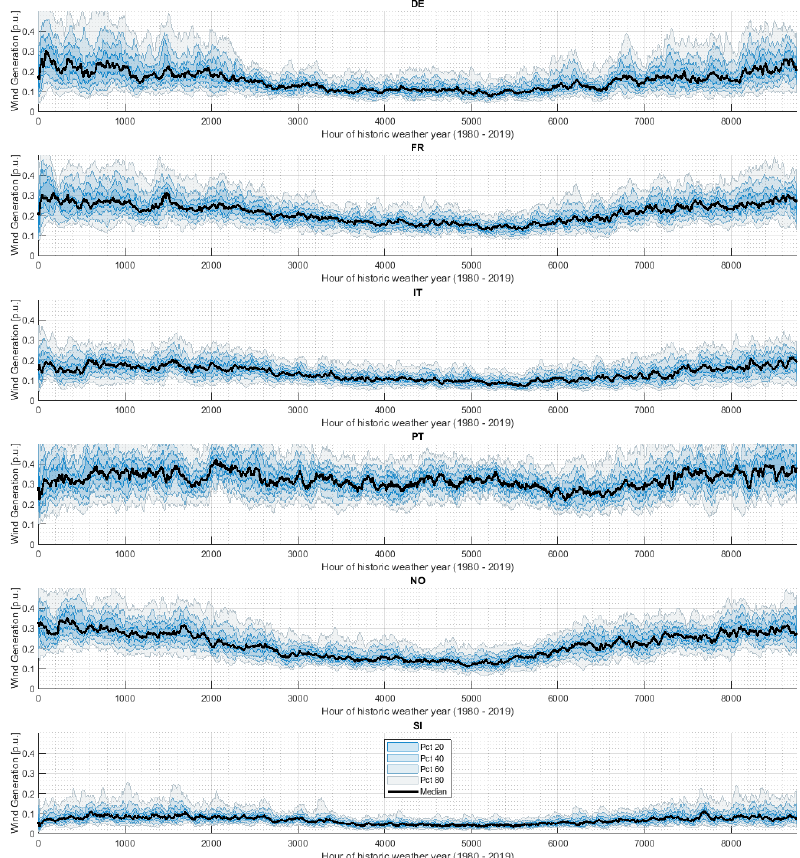
Figure 11. Normalised hourly wind power generation potential from 1980 to 2019 in selected European countries.